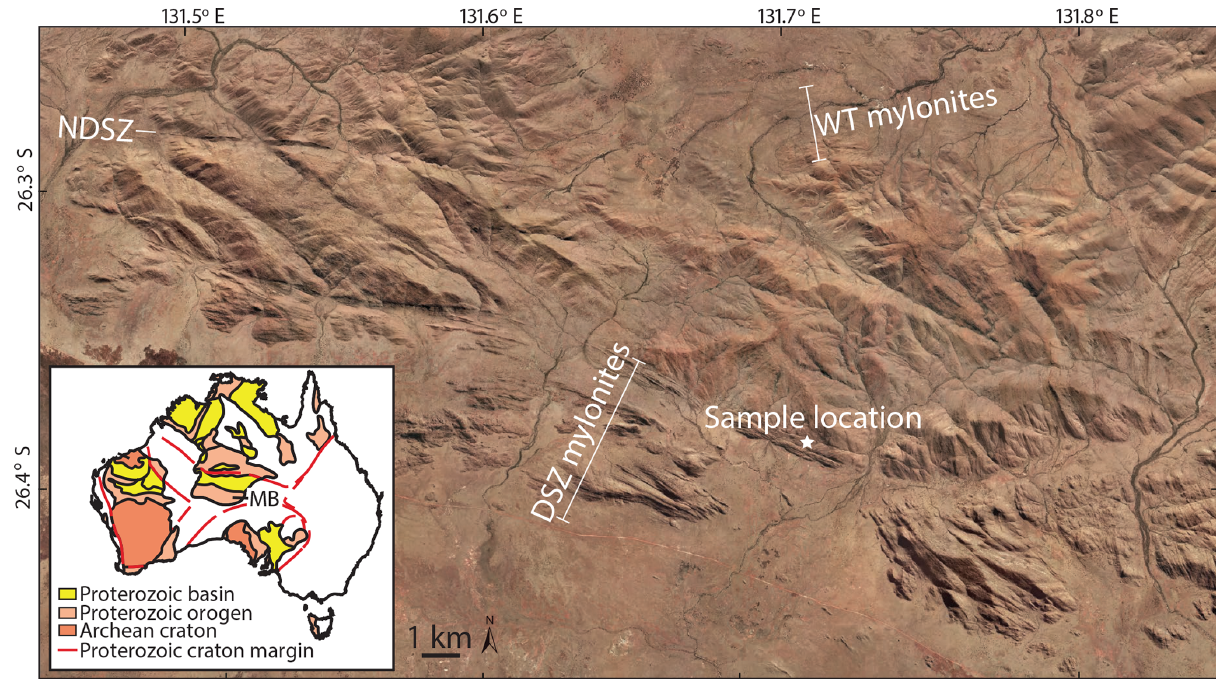
Figure 1. Airborne imagery of the study area with the sample location (26.3849 ◦ S, 131.7067 ◦ E) in the Davenport Shear Zone (DSZ). NDSZ stands for the North Davenport Shear Zone, and WT stands for the Woodroffe Thrust. The image is from the Department of Primary Industries and Regions, South Australia (PIRSA), 2012. The inset is the location of the Musgrave Block (MB) in between the amalgamated Australian cratons. This was modified after Evins et al.